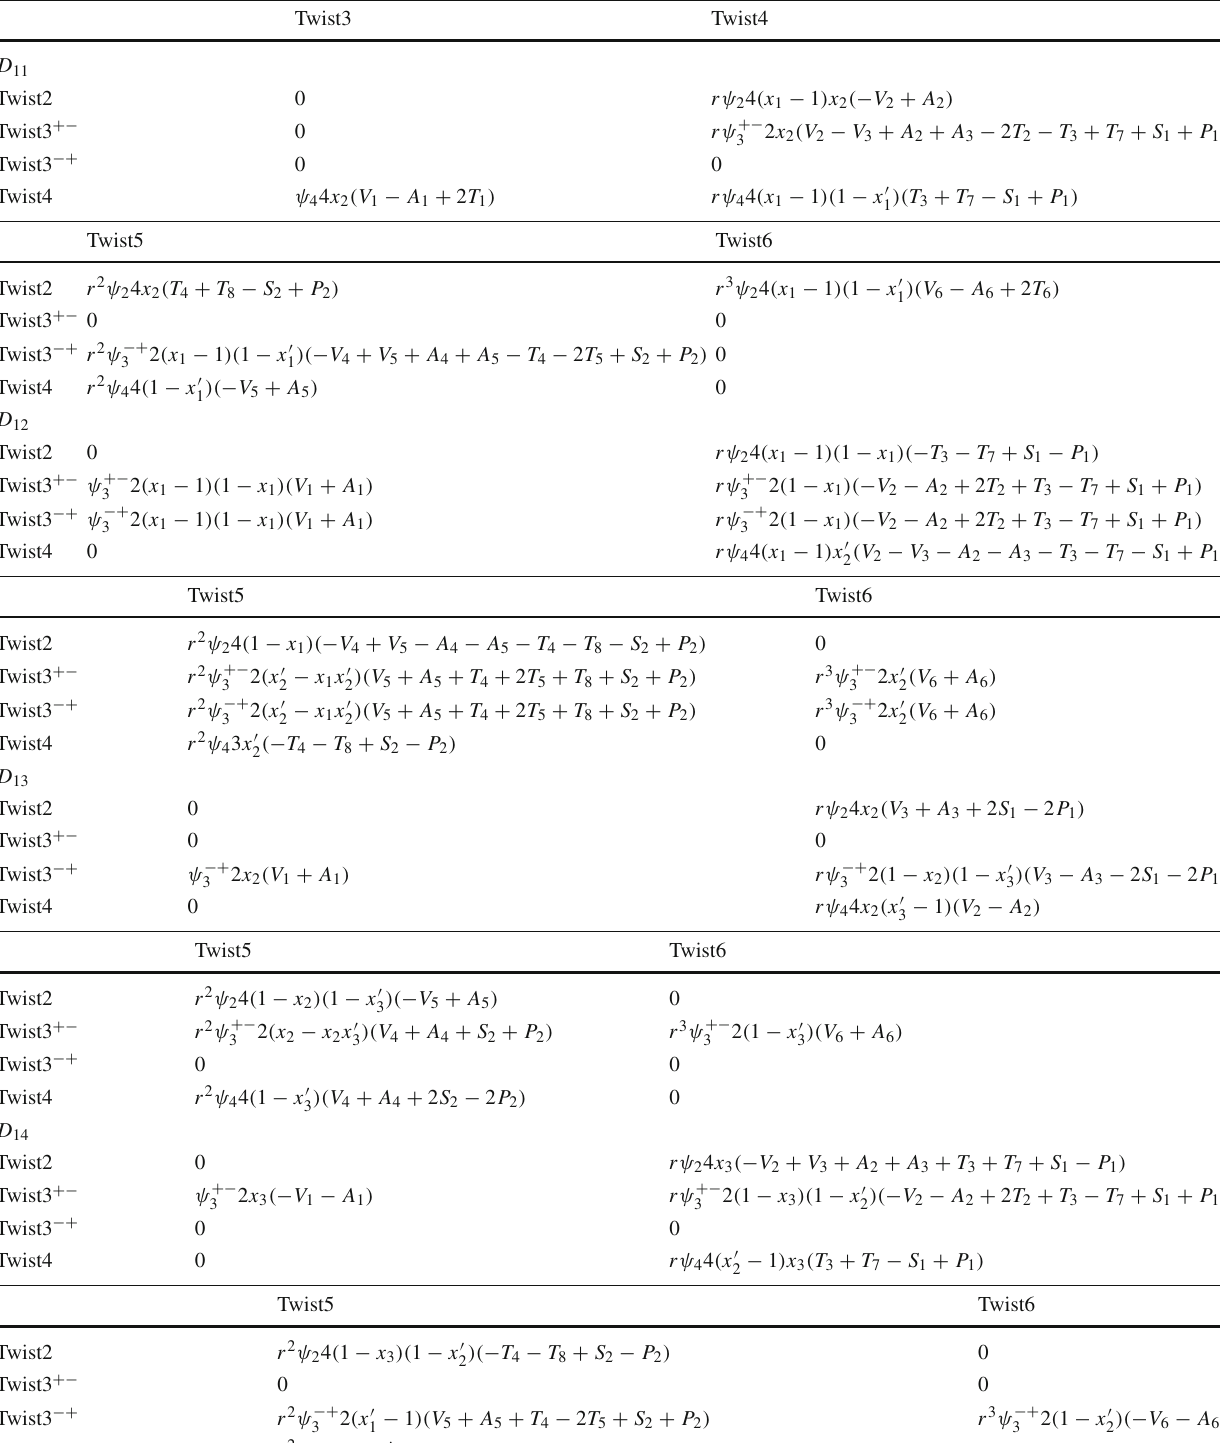
Table 16 The same as Table 5 but for the diagrams D 11 , D 12 , D 13 and D 14 in Fig. 1 Twist3